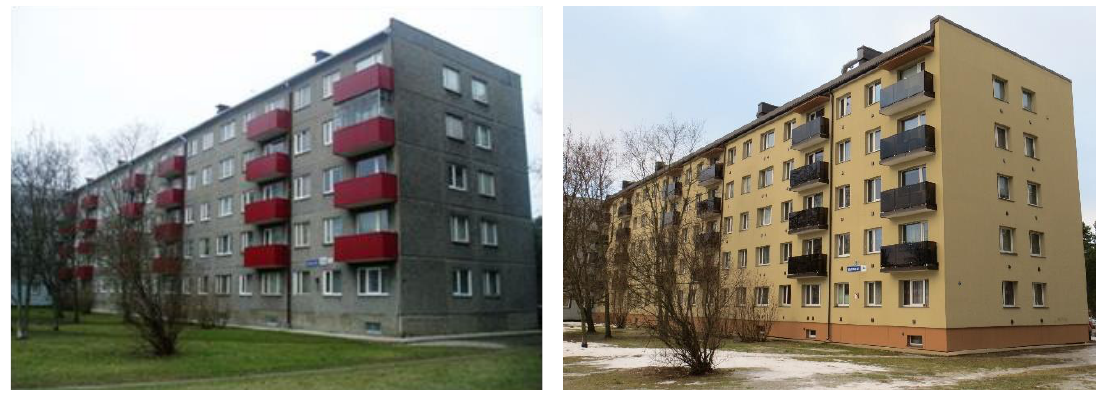
Figure 2. Overview of the reference building in 2014 before ( left ) and in 2015 after ( right ) the renovation.